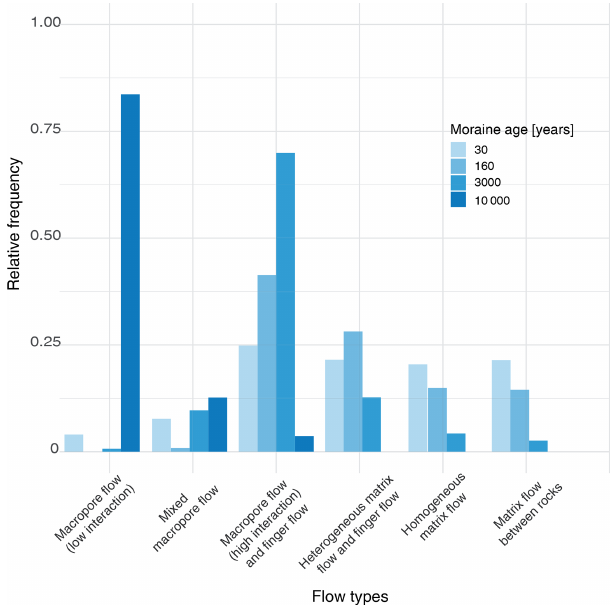
Figure 10. Relative frequency distribution of flow types of the four moraine age classes. Basically all observations fit into the six flow type categories. The fraction of observations categorized as “unde- fined flow type” is